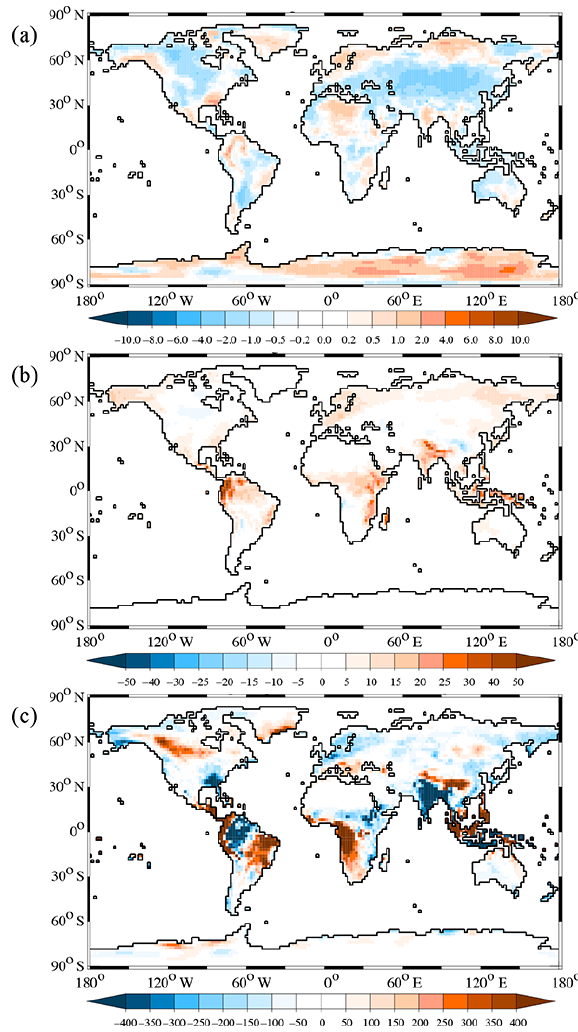
Figure 15. (a) Annual surface air temperature ( ◦ C), (b) annual sur- face incoming shortwave radiation (Wm − 2 ), and (c) annual total precipitation (mmyr − 1 ) differences (TEST-NUDG minus reference